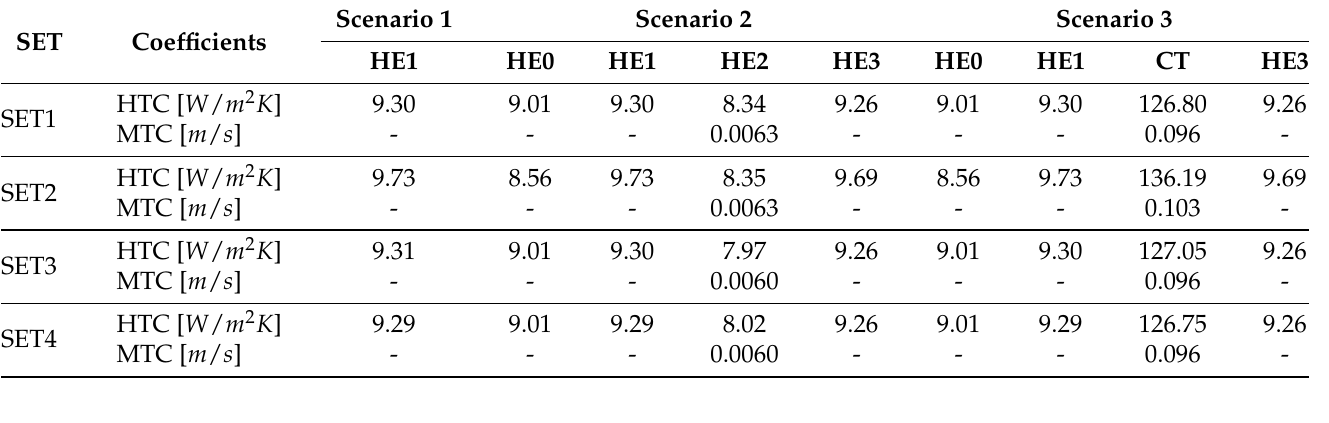
Table 3. The heat and mass transfer coefficients of the heat exchangers.